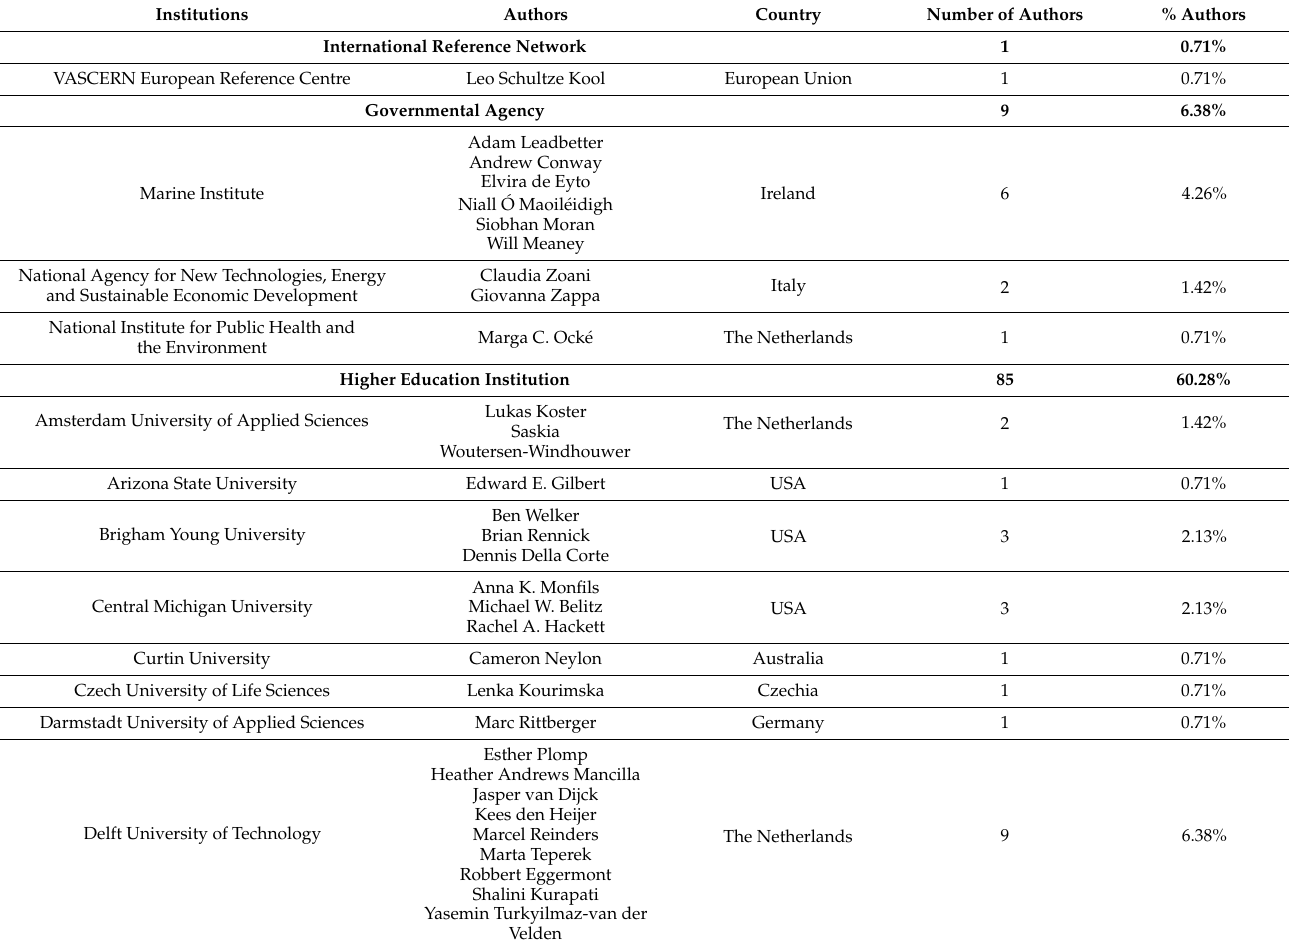
Table A4. Distribution of authors per organization, by type of